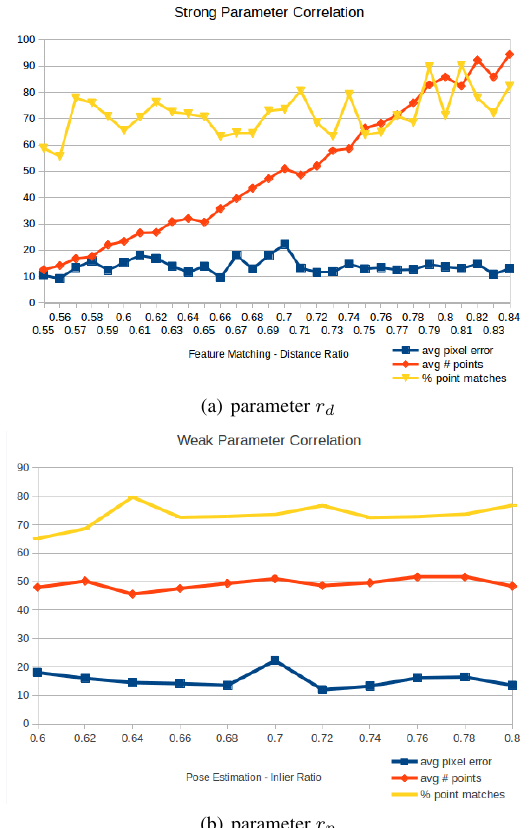
Figure 8: Graphs showing the difference between strongly-correlated parameters (such as r d in (a)) and weakly-correlated parameters (such as r p in (b)) by observing average pixel errors, number of detected features and ratio of correct correspondences.